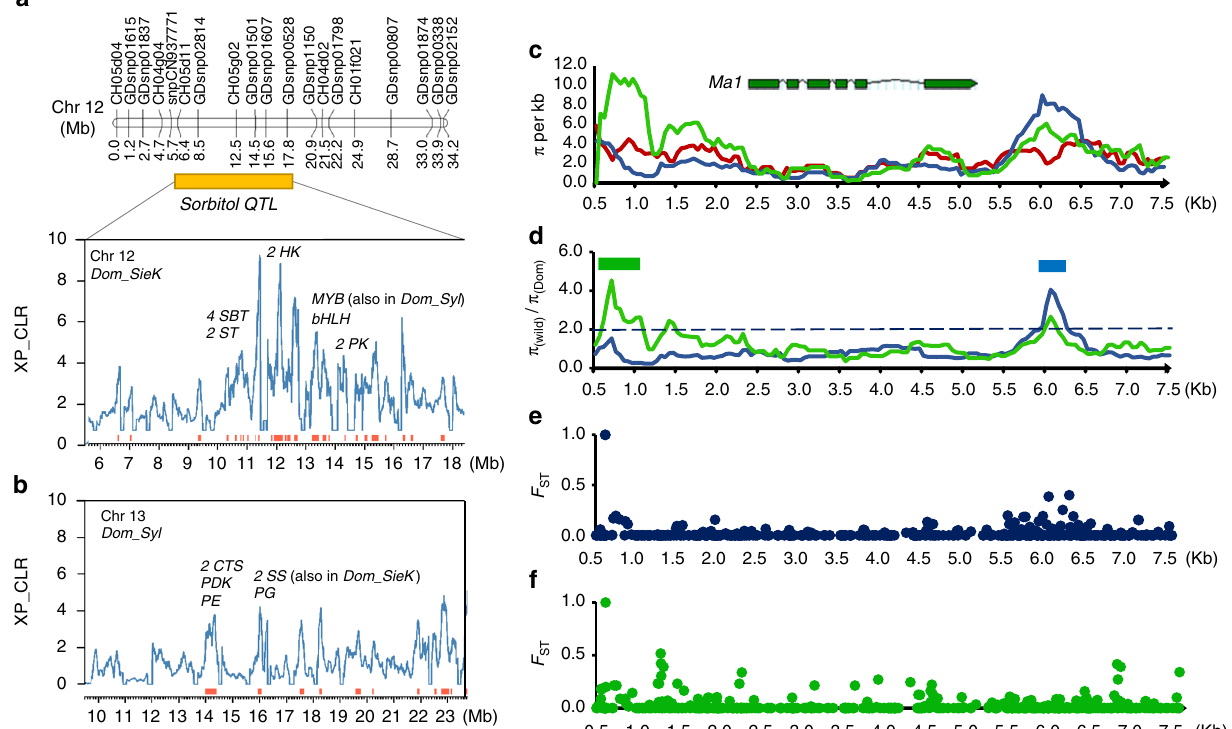
Fig. 6 Domestication of fruit sweetness and acidity in apples. a Selective sweeps from M. sieversii in Kazakhstan that co-localize with a sorbitol QTL. b Domestication sweeps from M. sylvestris that contain key genes for sugar metabolism. Distributions of XP-CLR scores are shown. Selective sweeps are marked with red bars and interesting genes are labeled above peaks. c – f Domestication of the Ma1 gene that regulates apple fruit acidity. c Distributions of nucleotide diversity ( π ) of M. domestica ( red ), M. sieversii in Kazakhstan ( blue ), and M. sylvestris ( green ) in the Ma1 genome region. d Ma1 selective sweeps during domestication from M. sieversii in Kazakhstan ( blue ) and M. sylvestris ( green ). Sweep regions are marked with fi lled boxes . e Distribution of F ST between M. domestica and M. sieversii in Kazakhstan in the Ma1 genome region. f Distribution of F ST between M. domestica and M. sylvestris in the Ma1 genome region. bHLH transcription factor, CTS citrate synthase, HK hexokinase, MYB transcription factor, PDK pyruvate dehydrogenase kinase, PE